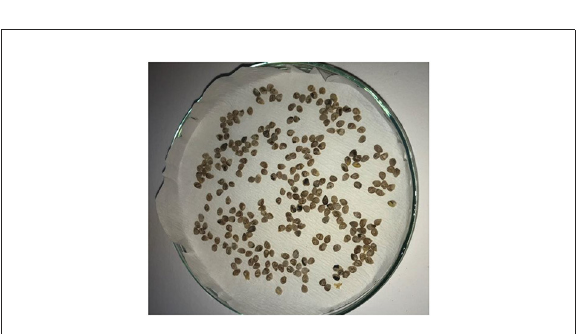
FIGURE2 Color changes observed in tomato seeds.